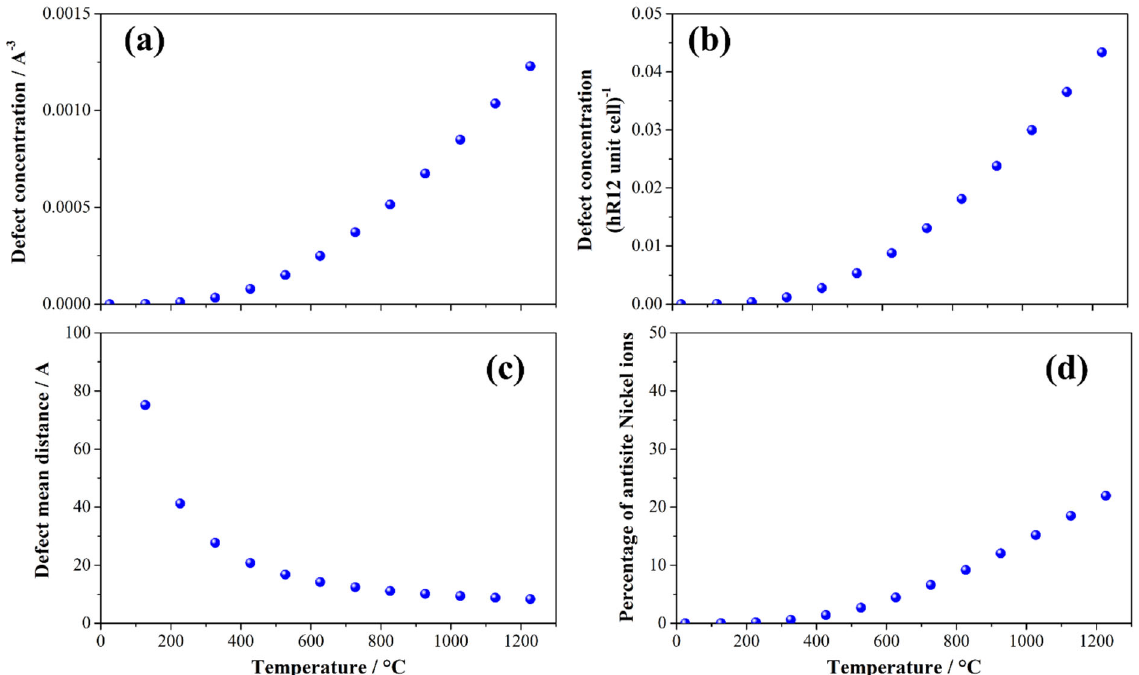
Figure 5. Concentration of the antisite defects in the LRLO lattice normalized ( a ) by formula unit (C antisite (f.u. − 1 )) or ( b ) by volume of cell (C antisite (Å − 3 )) as a function of the temperature. ( c ) Estimated mean distance between antisite defects and ( d ) fraction of nickel ions in the LRLO phase that occupied an antisite position.